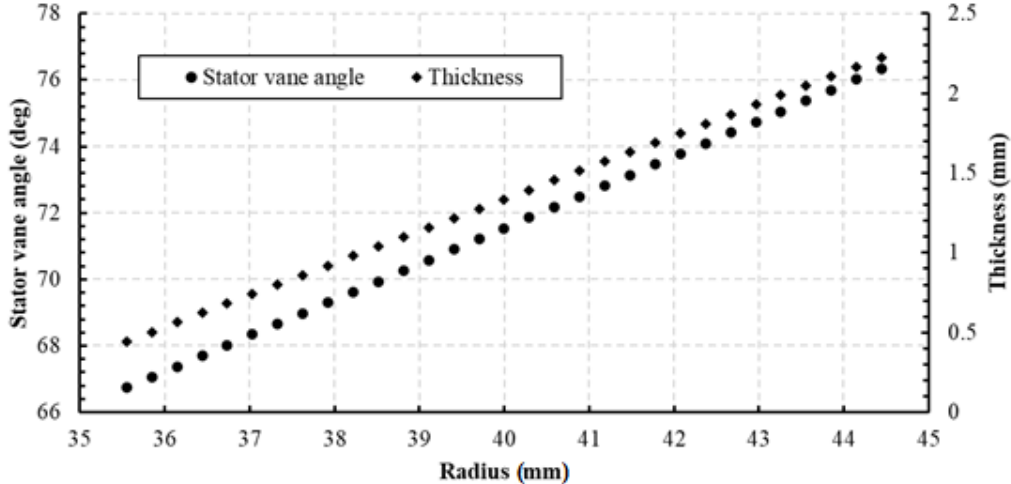
Figure 5. Distributions of vane angle and thickness of stator.